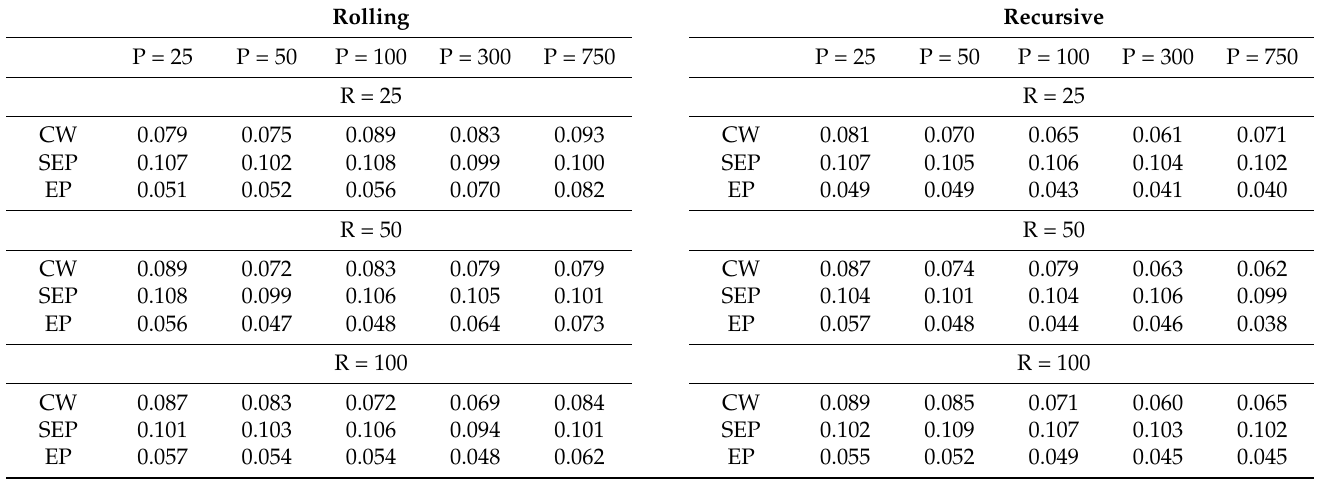
Table 2. Empirical Size DGP2, Nominal size is